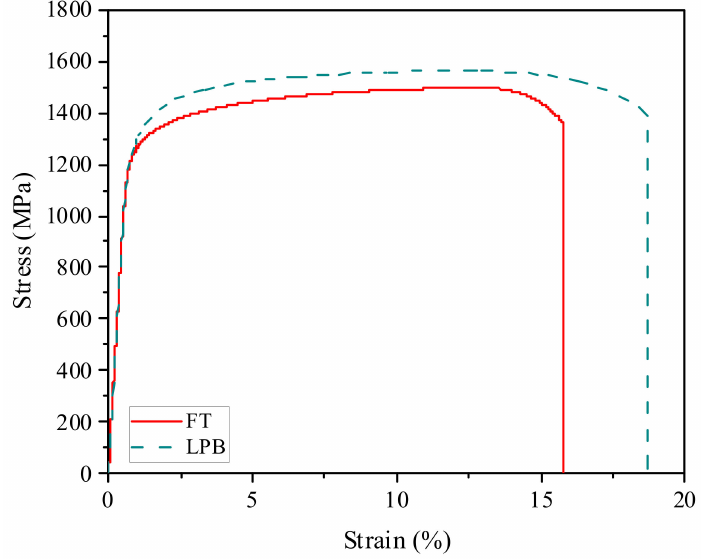
Figure 15. Stress–strain curves of Inconel 718 for FT (red) and LPB (green)